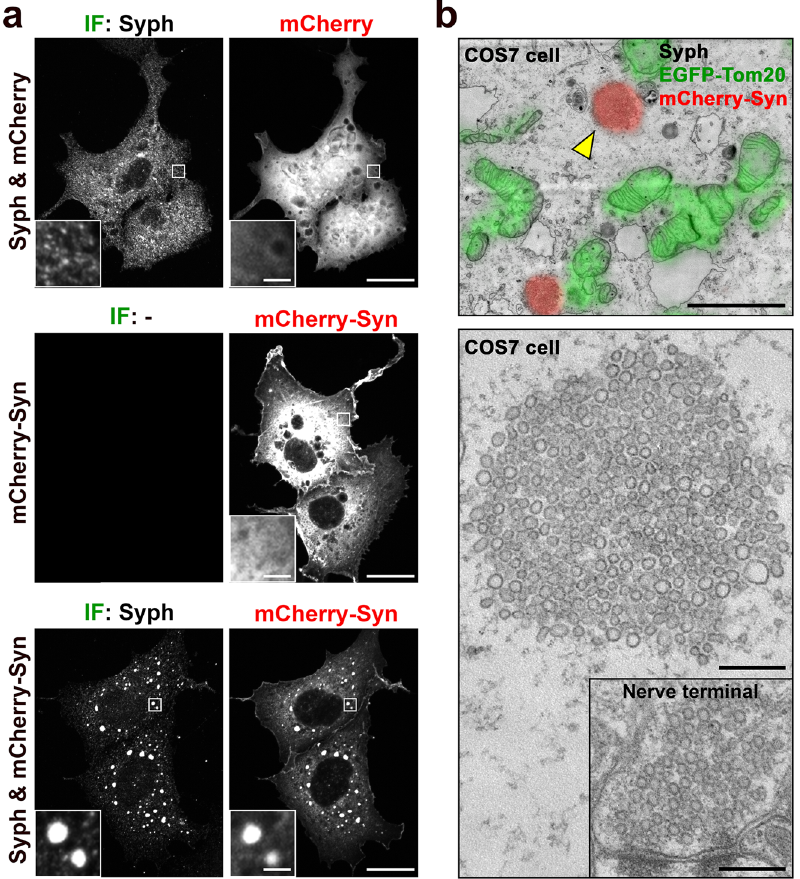
Fig. 1 Co-expression of synaptophysin with mCherry-synapsin in non-neuronal cells results in droplets represented by clusters of small vesicles resembling SVs. a COS7 cells were transfected as indicated and synaptophysin was detected by immuno fl uorescence (IF). Insets shows small regions at higher magni fi cation. b Correlative light electron microscopy (CLEM) of COS7 cells expressing synaptophysin, mCherry-synapsin and EGFP-TOM20. Top: superimposition of fl uorescence and EM. The arrowhead point to the spot whose EM appearance is shown at higher magni fi cation at the bottom. Inset: a synaptic vesicle cluster in the nerve terminal of a mouse brain section is shown at the same magni fi cation as a comparison. Scale bars, a = 20 μ m (2 μ m for insets), b = 2 μ m (top) or 200 nm (bottom and